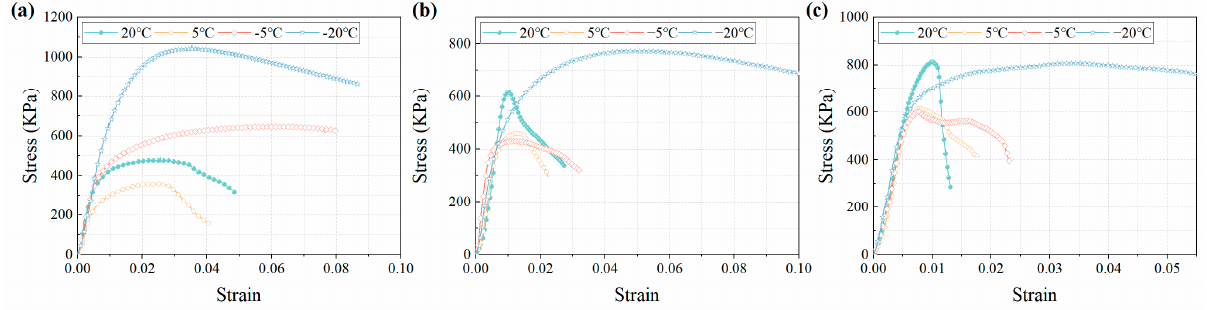
Figure 6. Stress–strain characteristics of CTB with CTR of 1:12 at different curing temperatures. ( a ) 3 days, ( b ) 7 days, ( c ) 28 days.